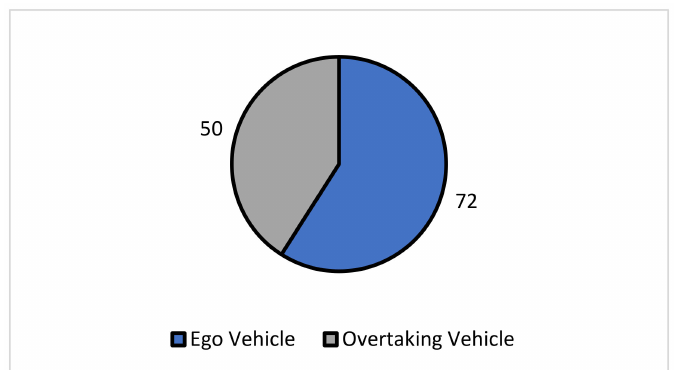
Figure 15. System usability